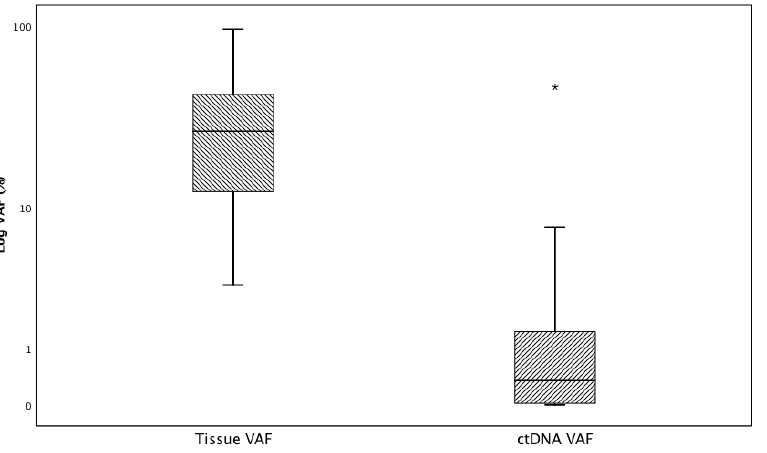
Figure 2. Variant Allelic Fraction of alterations found in tumor tissue and plasma ctDNA. * p <